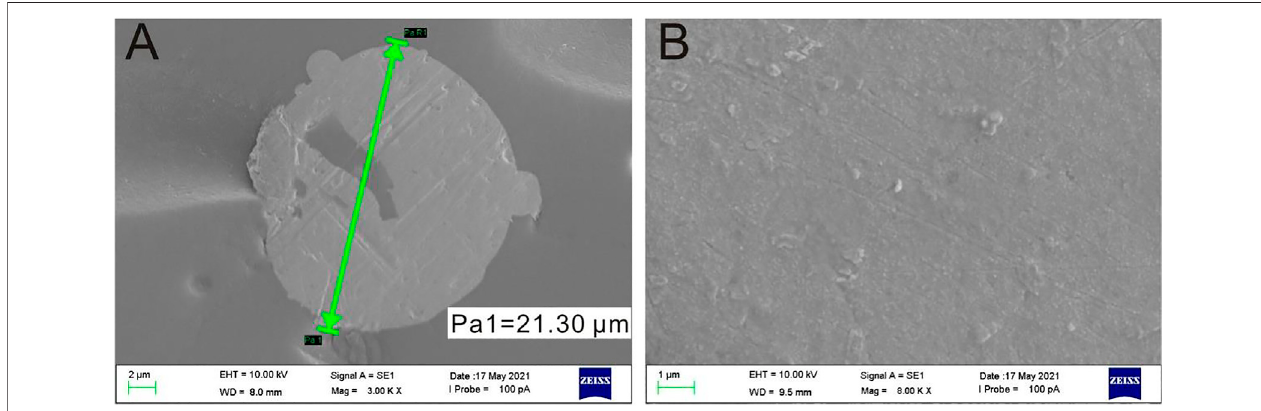
FIGURE 2 | SEM images of the bare Pt μ E (A) and gold nanoparticle fi lm covered onto the surface of the Pt μ E (B) .